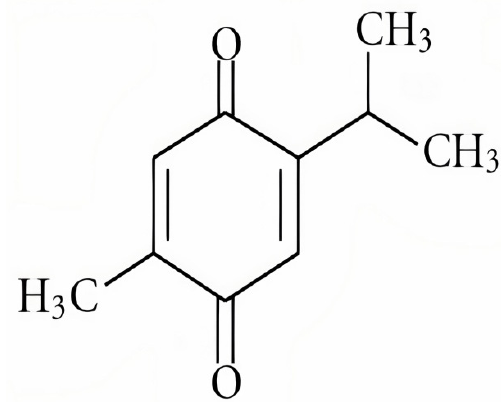
Figure 1. The chemical structure of thymoquinone [24].